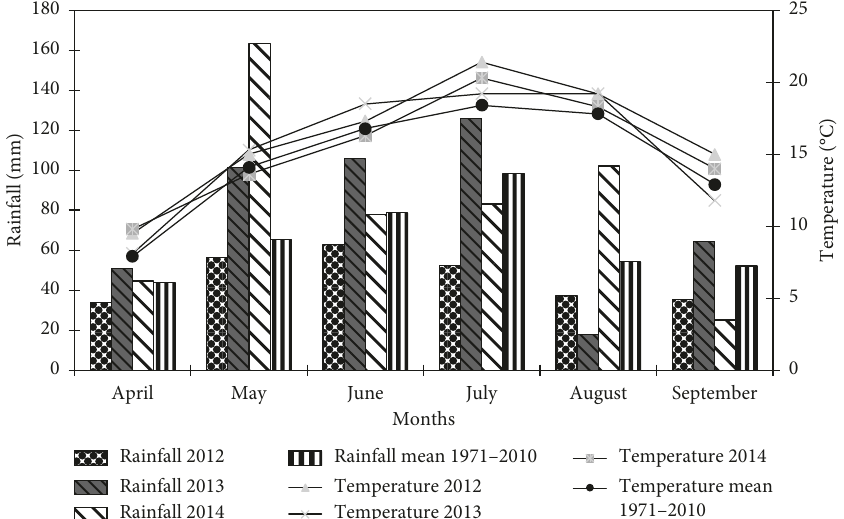
Figure 1: Rainfall and air temperature in months 4–9 as compared to the long-term means (1971–2010), according to the Meteorological Station in Zamo´s´c. Table 3: The influence of Mo and S application on the methionine and cysteine content. Treatment Values with different letters differ significantly ( P � 0 . 05); small letters in the column: treatments; capital letters in line: years.